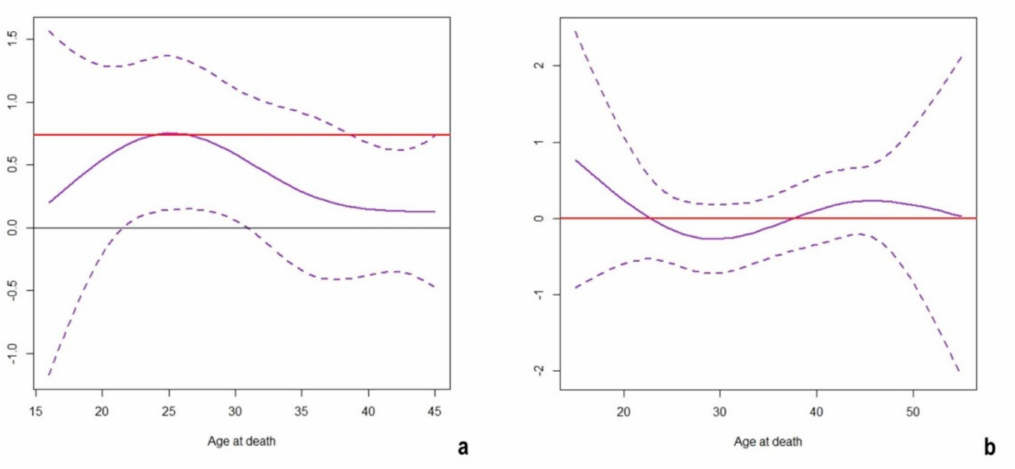
Figure 6. Estimated Hazard Ratio (HR) logarithm of females vs. males over time (95% confidence band) in Roman Imperial ( a ) and Medieval ( b ) analyzed populations. The red line corresponds to the estimated parameter (reported in Table 1), assuming it as